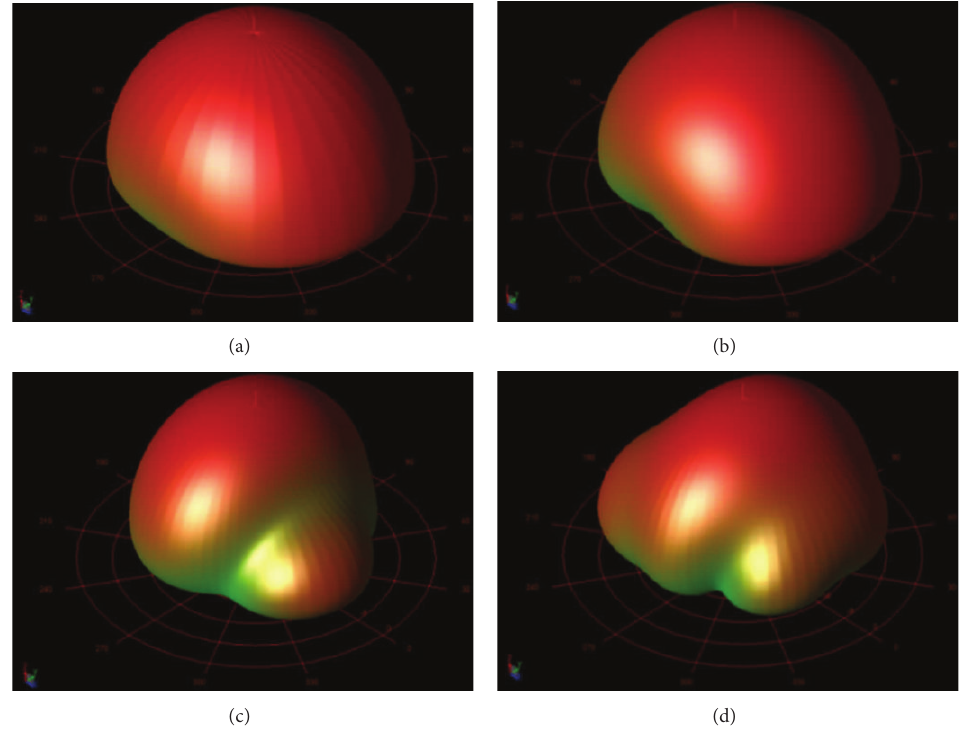
Figure 12: Simulated three-dimensional (3D) radiation gain patterns of the proposed antenna composed of four unit cells in elevation plane ( Φ = 0 ∘ ) and at operation frequencies: (a) at 4.3GHz, (b) at 7GHz, (c) at 17GHz, (d) at 18GHz.